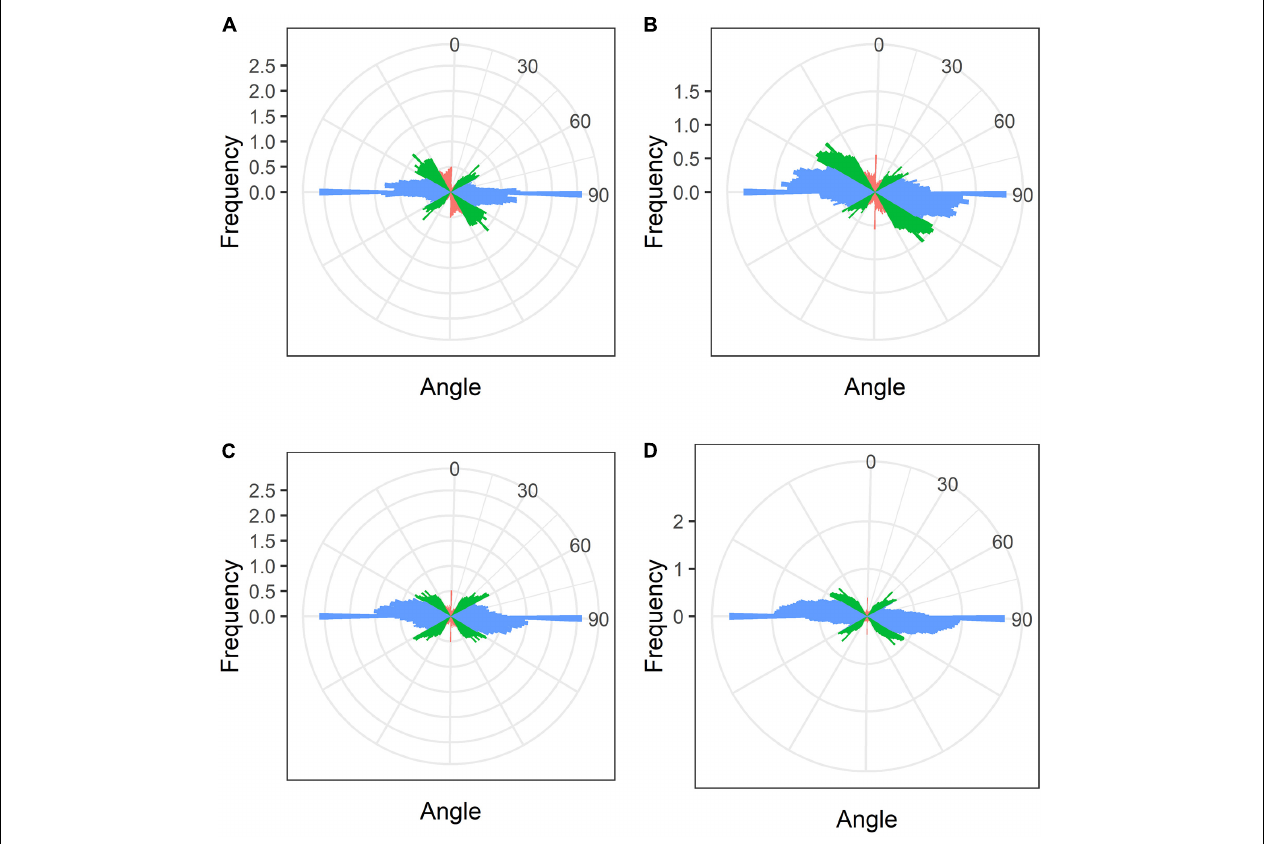
FIGURE 8 | Quantitative analysis of cortical microtubule orientation in infected cells of the nitrogen fixation zone of G. max (A) , G. soja (B) , P. vulgaris (C) , and L. japonicus (D) nodules. Color indicates the class of angles of the microtubules relative to the longitudinal axis of the cell: red, axial (0–30 ◦ , 150–180 ◦ ); green, oblique (30–60 ◦ , 120–150 ◦ ); blue, transverse (60–120 ◦